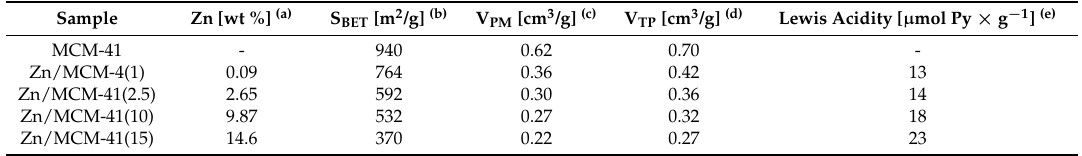
Table 1. Textural properties of studied